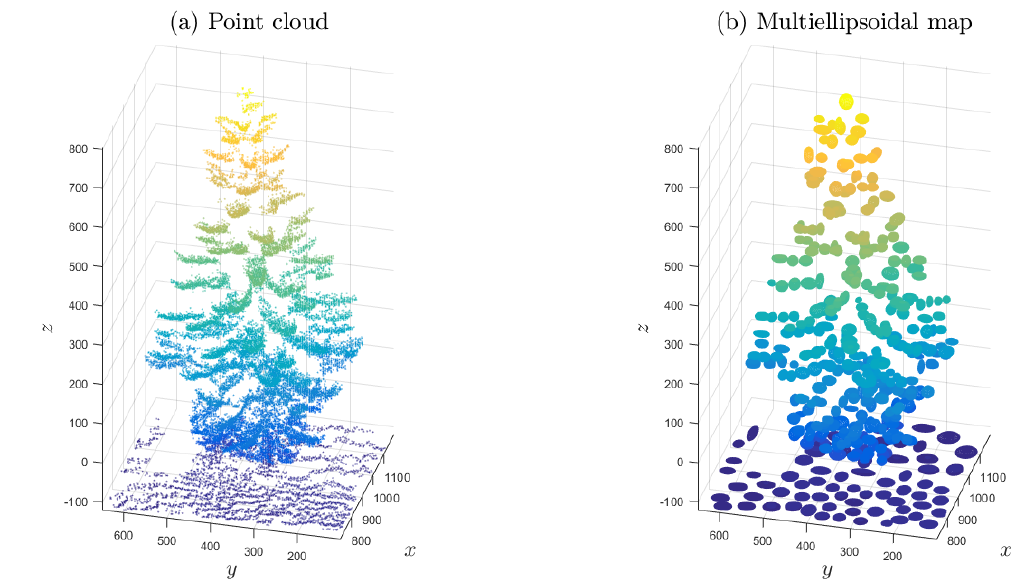
Figure 4. Experiment 2.